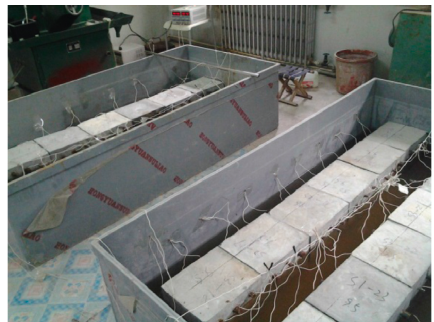
Figure 5: Energized accelerate steel corrosion test.